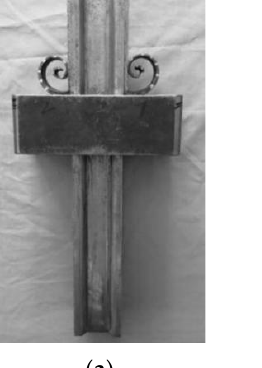
Figure 5. The shape of specimen. ( a ) Physical map; ( b ) sketch map.